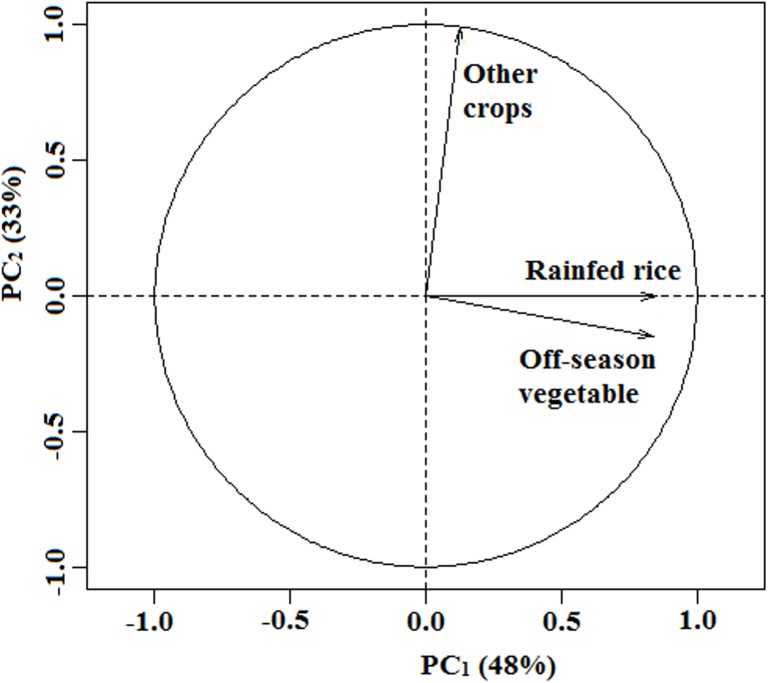
Projection of crop area on the first two axes of the principal components analysis.